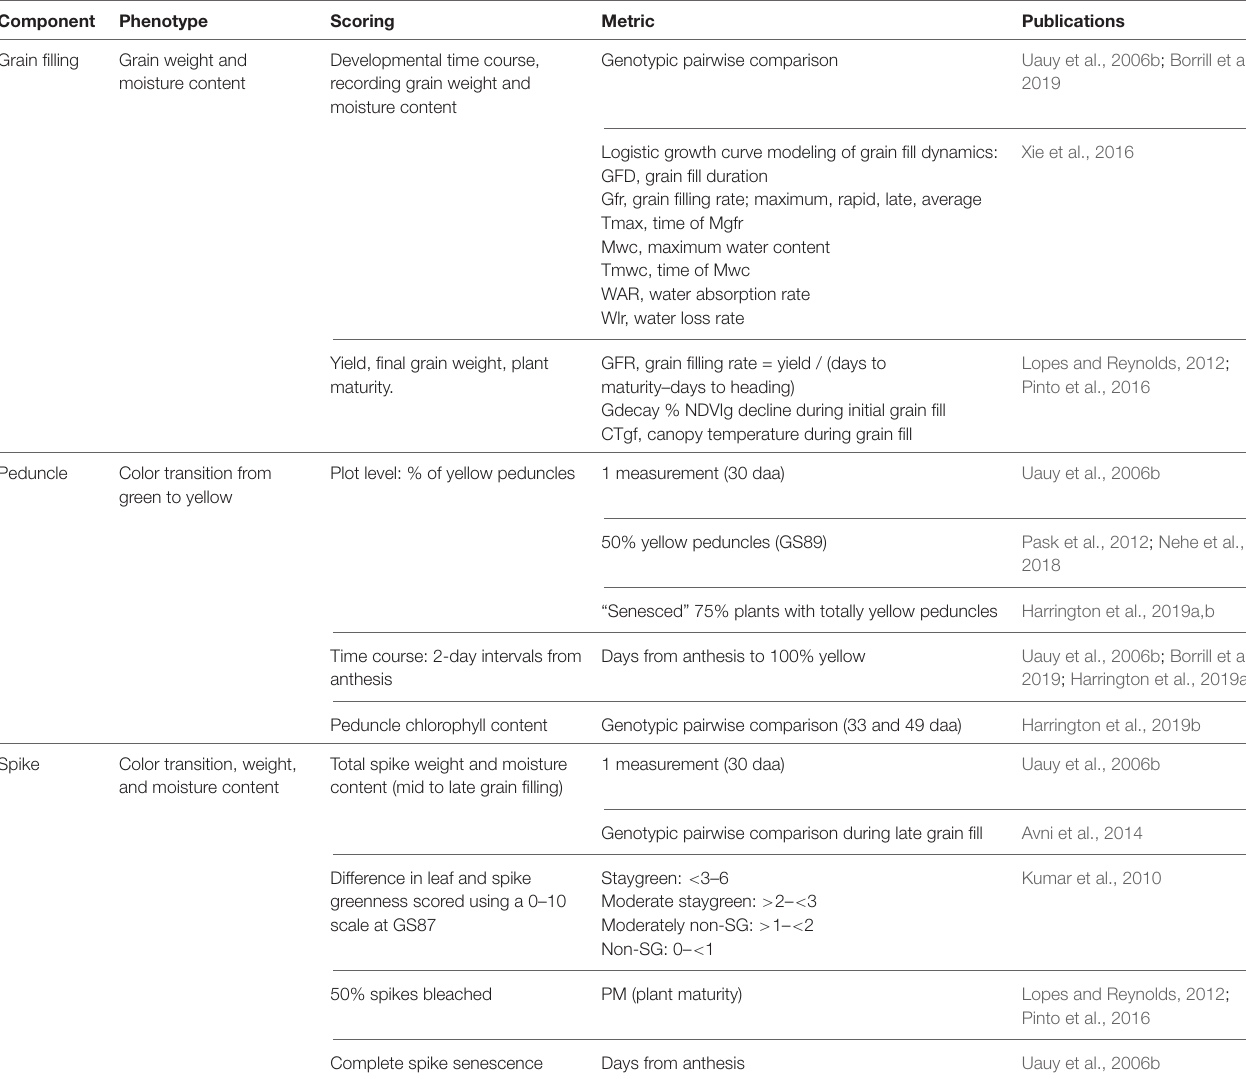
TABLE 2 | Senescence scoring efforts should not be limited to leaves. Senescence is a whole-plant process involving remobilization of resources into grain, for which studying multiple organs has been used to aid our understanding. Component